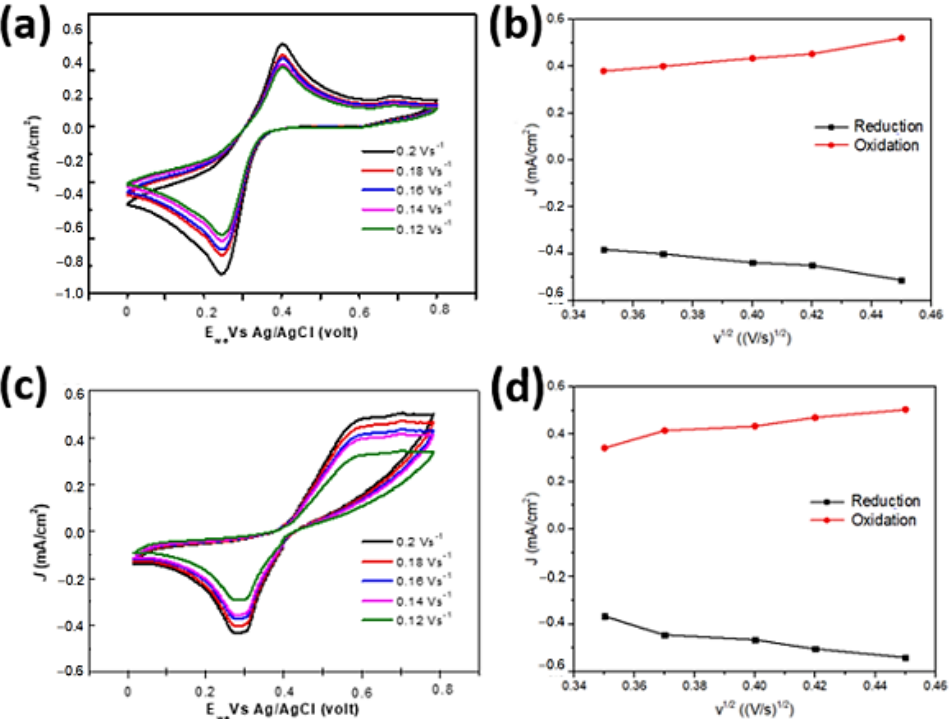
Figure 3. ( a ) CV curve of the ZnO/Au thin film in the 5 mM [Fe(CN) 6 ] 3−/4− solution and ( c ) CV curve of the ZnO/Au nanosquare array in 5.0 mM [Fe(CN) 6 ] 3−/4− and 0.2 mM of glucose analyte medium at various scan rates between 0.02 V s −1 up to 0.12 V s −1 . Graph that depicts the linearity between peak currents of reduction and oxidation at each scan rate for ( b ) ZnO/Au thin film and ( d ) ZnO/Au nanosquare array. Peak currents of oxidation (i pox ) on the ZnO/Au thin film: 0.250 mA/cm 2 – 0.538 mA/cm 2 , and peak currents of reduction (i pred ): − 0.199 mA/cm 2 –− 0.421 mA/cm 2 . Peak currents of oxidation (i pox ) on the ZnO/Au nanosquare array: 0.231 mA/cm 2 – 0.311 mA/cm 2 , and peak currents of reduction (i pred ): − 0.245 mA/cm 2 –− 0.353 mA/cm 2 at a concentration of 9.90 × 10 −5 mol L −1 . The data were taken from the inner part of the curve up to the outer part.